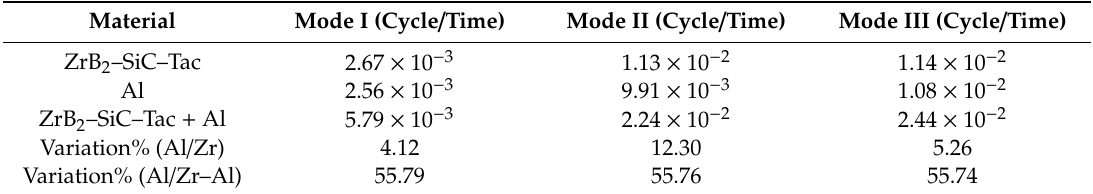
Table 4. First three modes corresponding to the aircraft wing natural